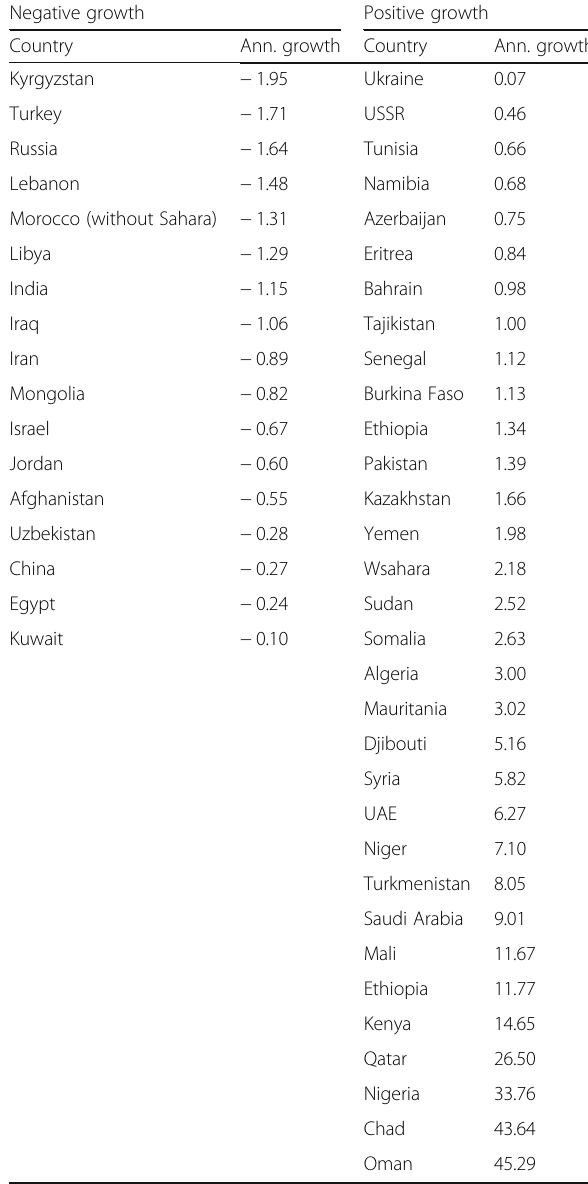
Table 1 Classification of the camel countries and national entities according to their mean growing annual growth (calculated from FAOStat 2020) Negative